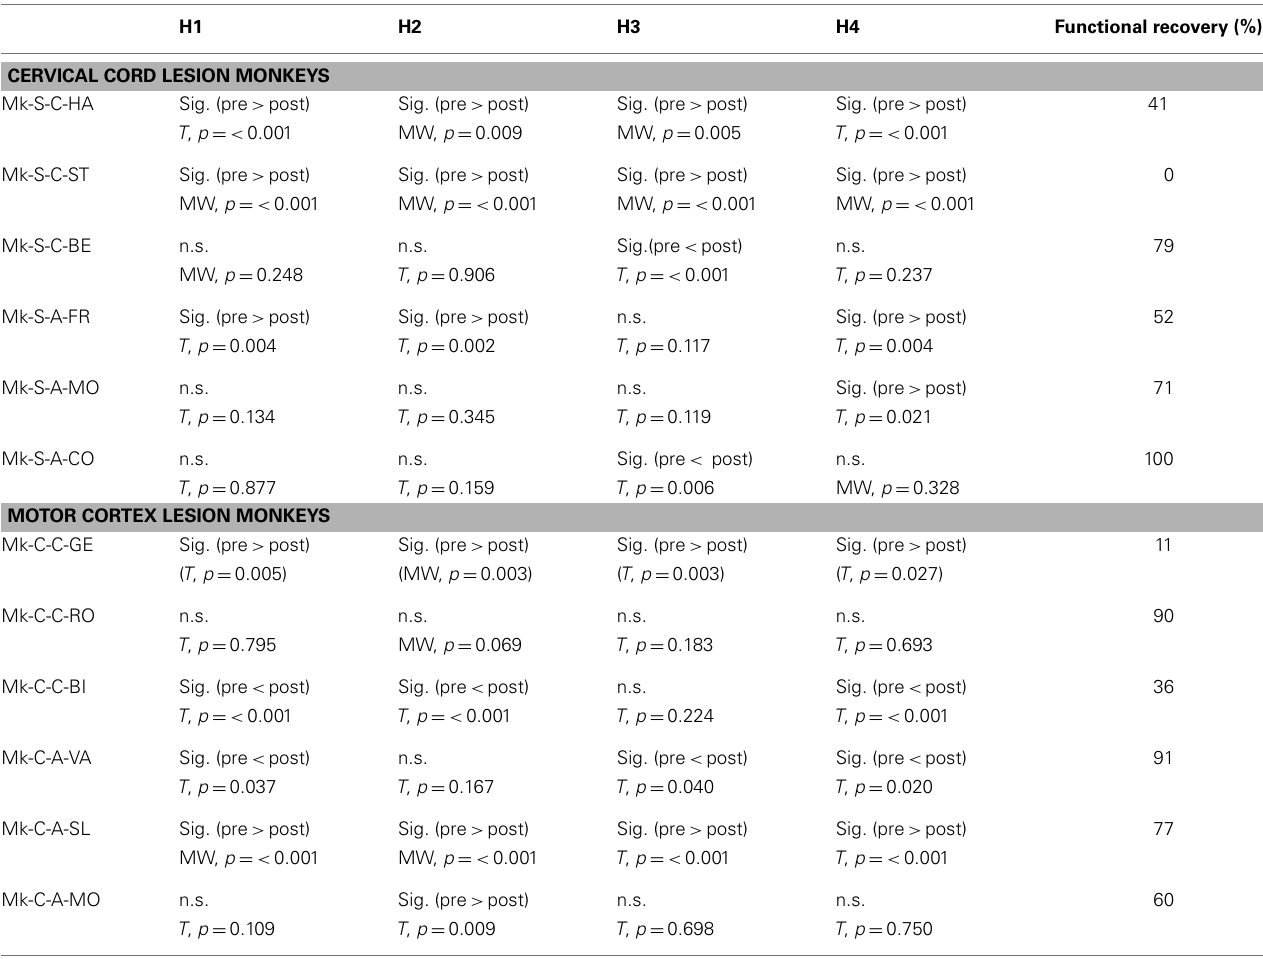
Table 2 | Statistical comparison of wrist angle (adduction) pre- versus post-lesion for horizontal slots. H1 H2 H3